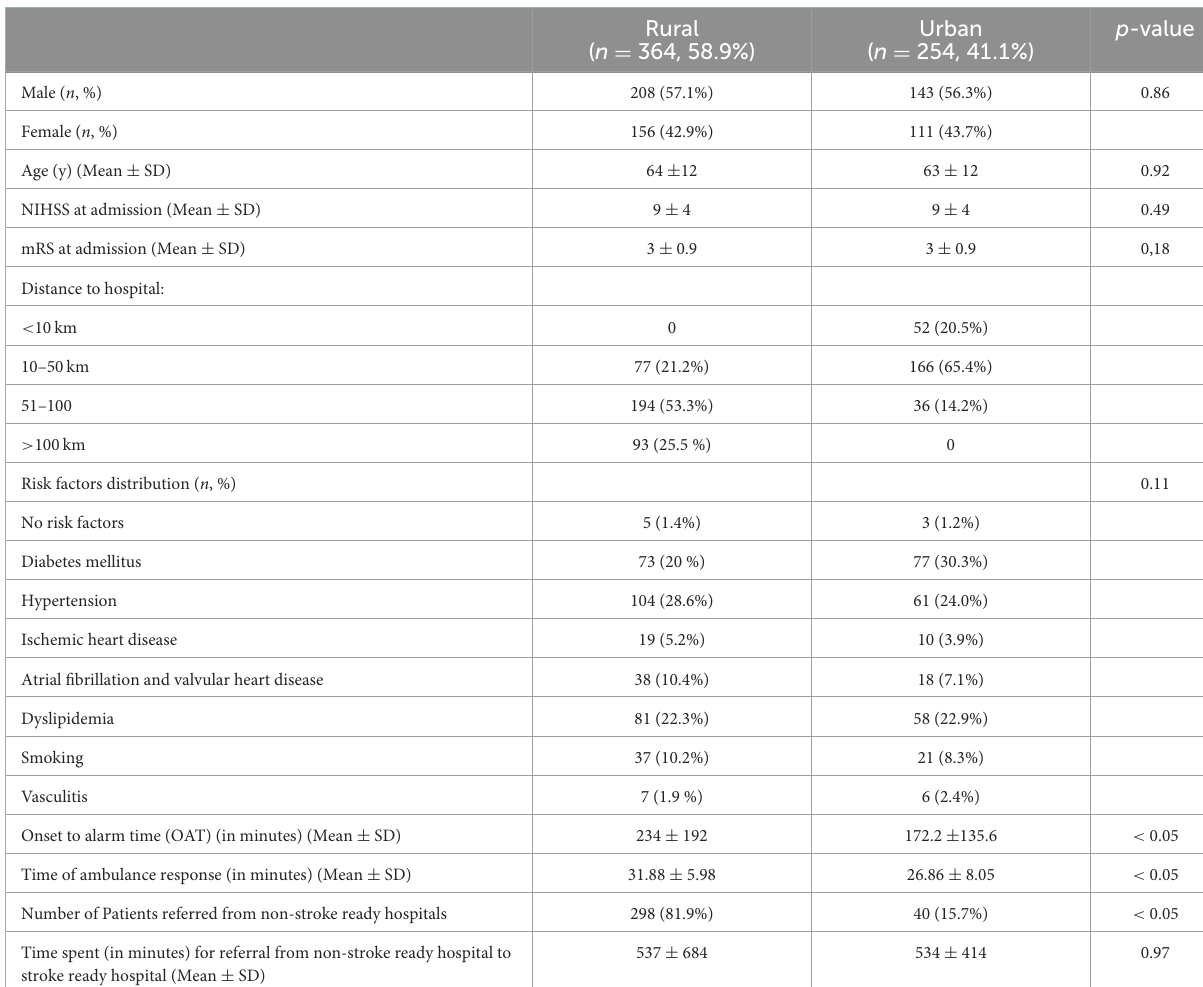
TABLE 1 General demographics of the study population.